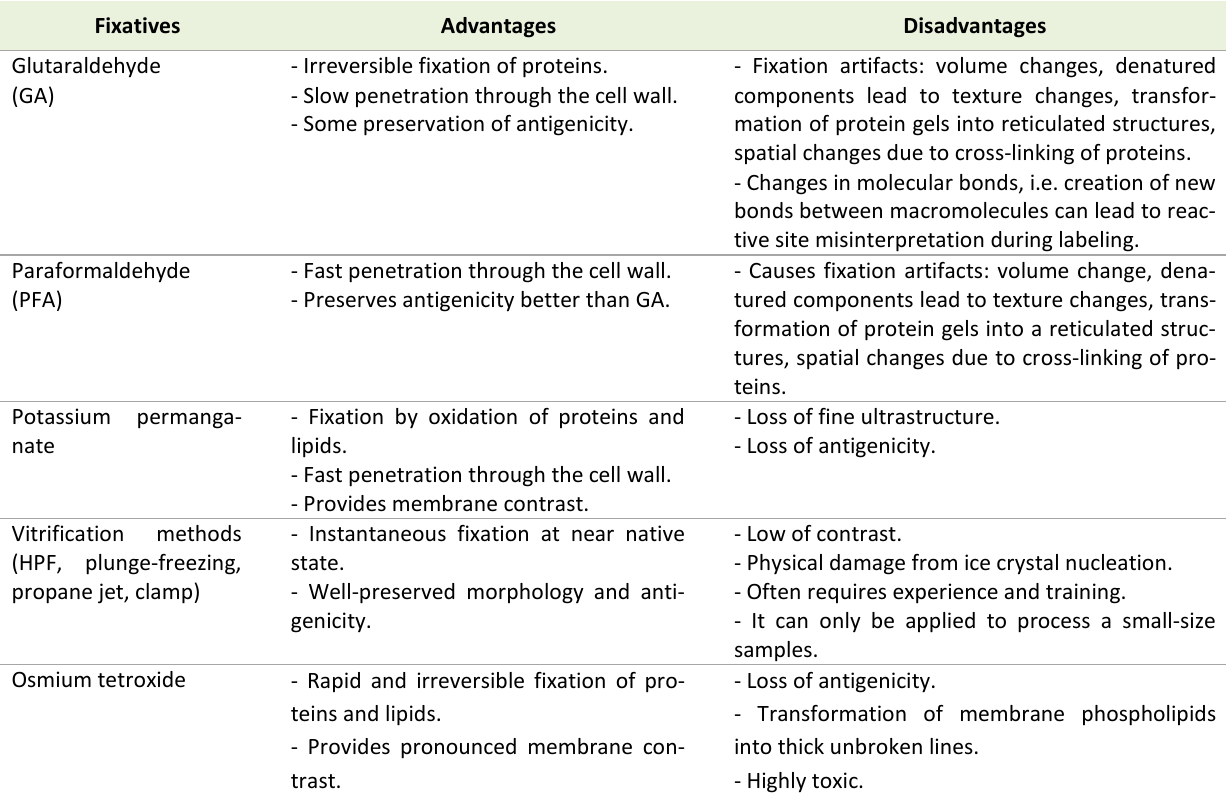
TABLE 1. Advantages and disadvantages of different types of